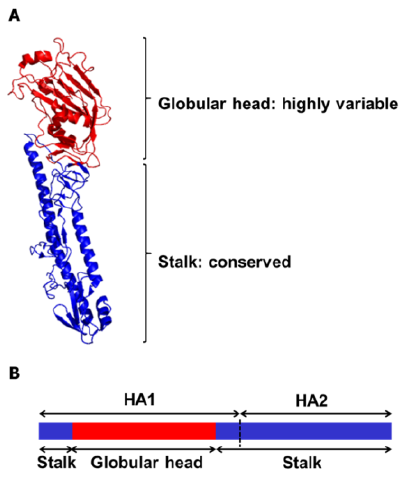
Figure 2. Ribbon diagram and schematic representation of the influenza HA